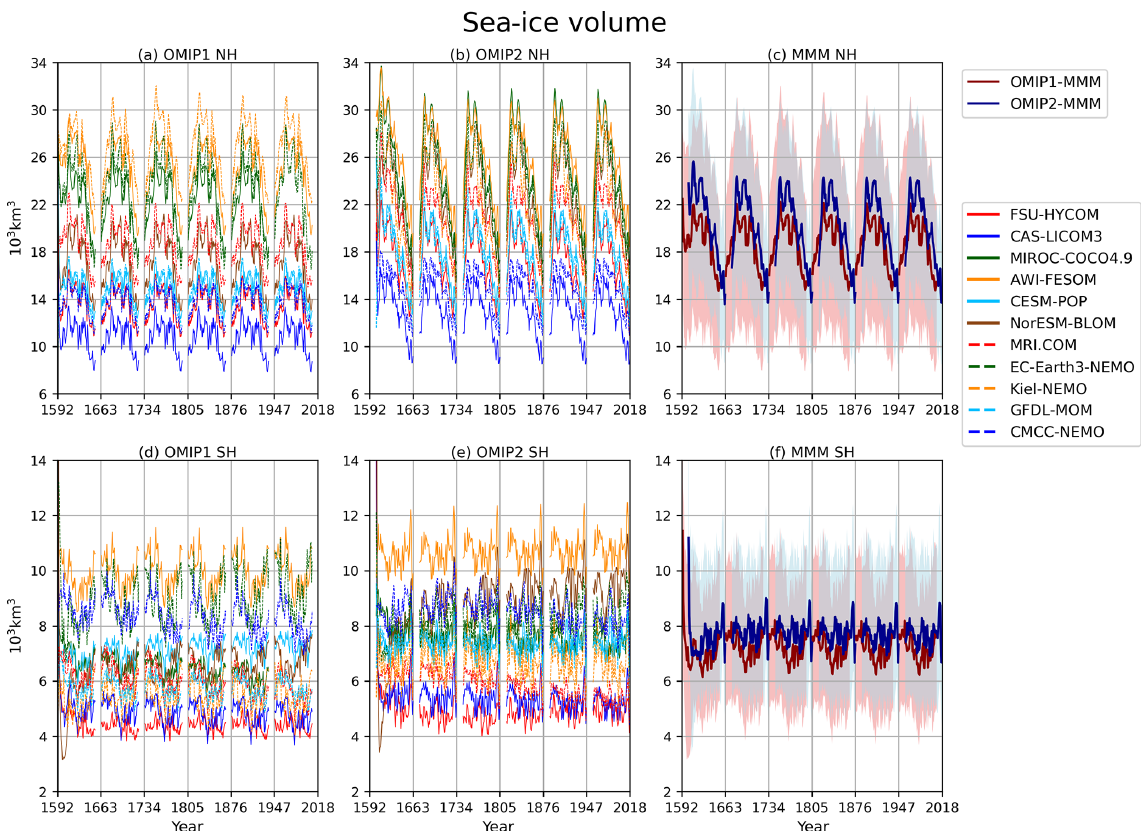
Figure 4. Time series of annual mean sea-ice volume integrated over the Northern Hemisphere (upper panels) and the Southern Hemisphere (lower panels): (a, d) OMIP-1 and (b, e) OMIP-2. (c, f) Multi-model mean (lines) and spread defined as the range between maximum and minimum (shades) of OMIP-1 (red) and OMIP-2 (blue). Units are 10 3 km 3 . See Fig. S7 for a closer look at individual